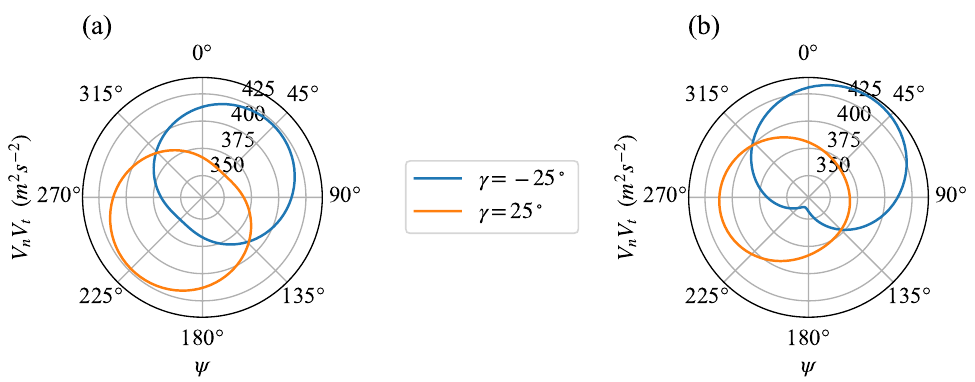
Figure 13. Azimuthal variations in V n V t at r = 0.7 R with respect to the blade phase angle ψ predicted by the BEM theory in ( a ) a uniform inflow u ( z ) = 11 m/s and ( b ) a vertically sheared inflow u ( z ) = u ∗ log ( z / z 0 ) , in which u ∗ = 0.45 m/s, κ = 0.4, and z 0 = 0.005 m. κ